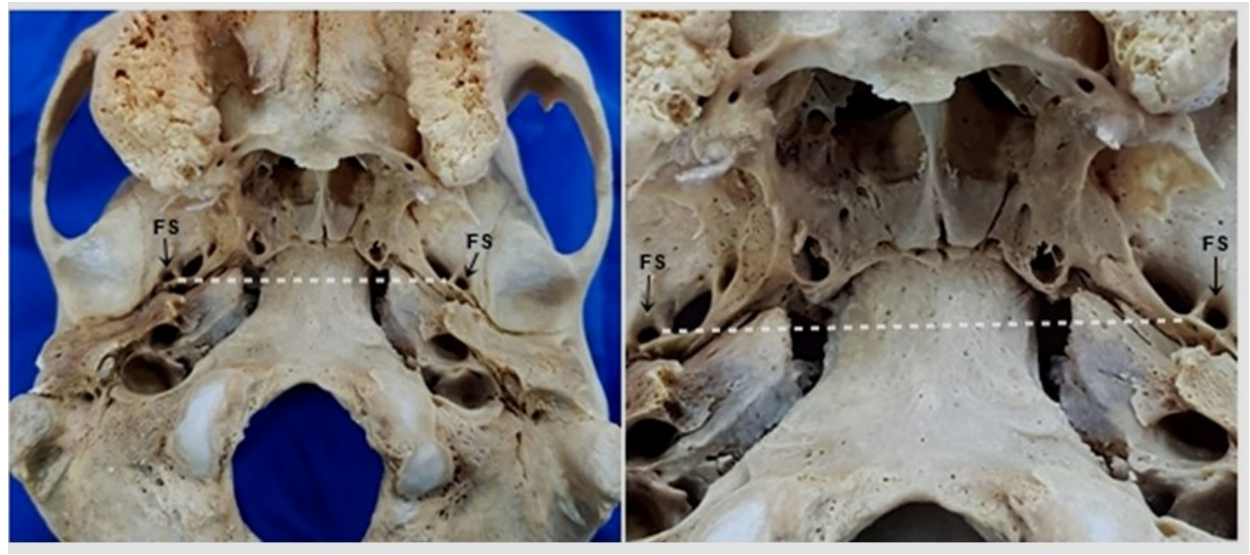
Figure 4. Inferior view of the skull. Note the position and symmetry of the foramen spinosum (FS) between the right and left sides.